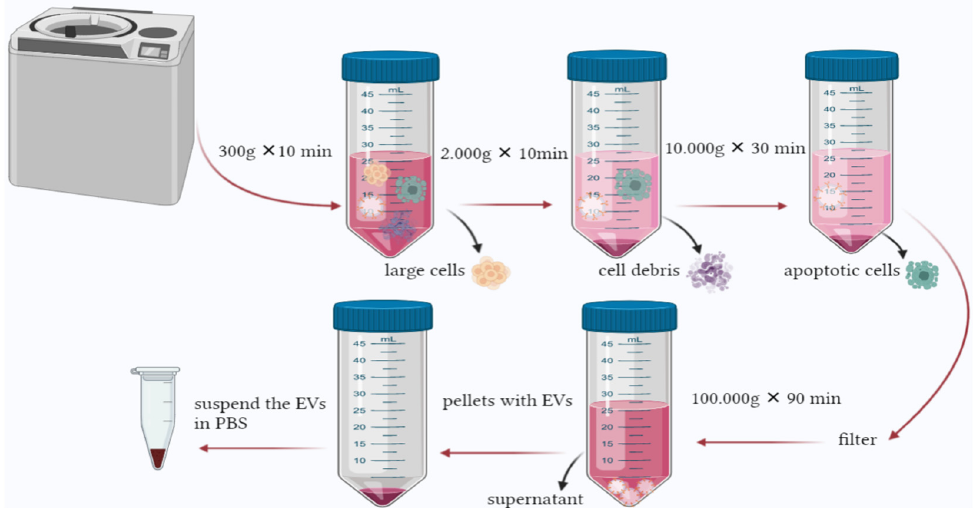
Figure 3. Ultracentrifugation is the most common method used to isolate EVs. The process is based on increasing the force and time gradually to pellet large cells and contaminants until reaching the final centrifugation, where EVs can be found in the pellet.